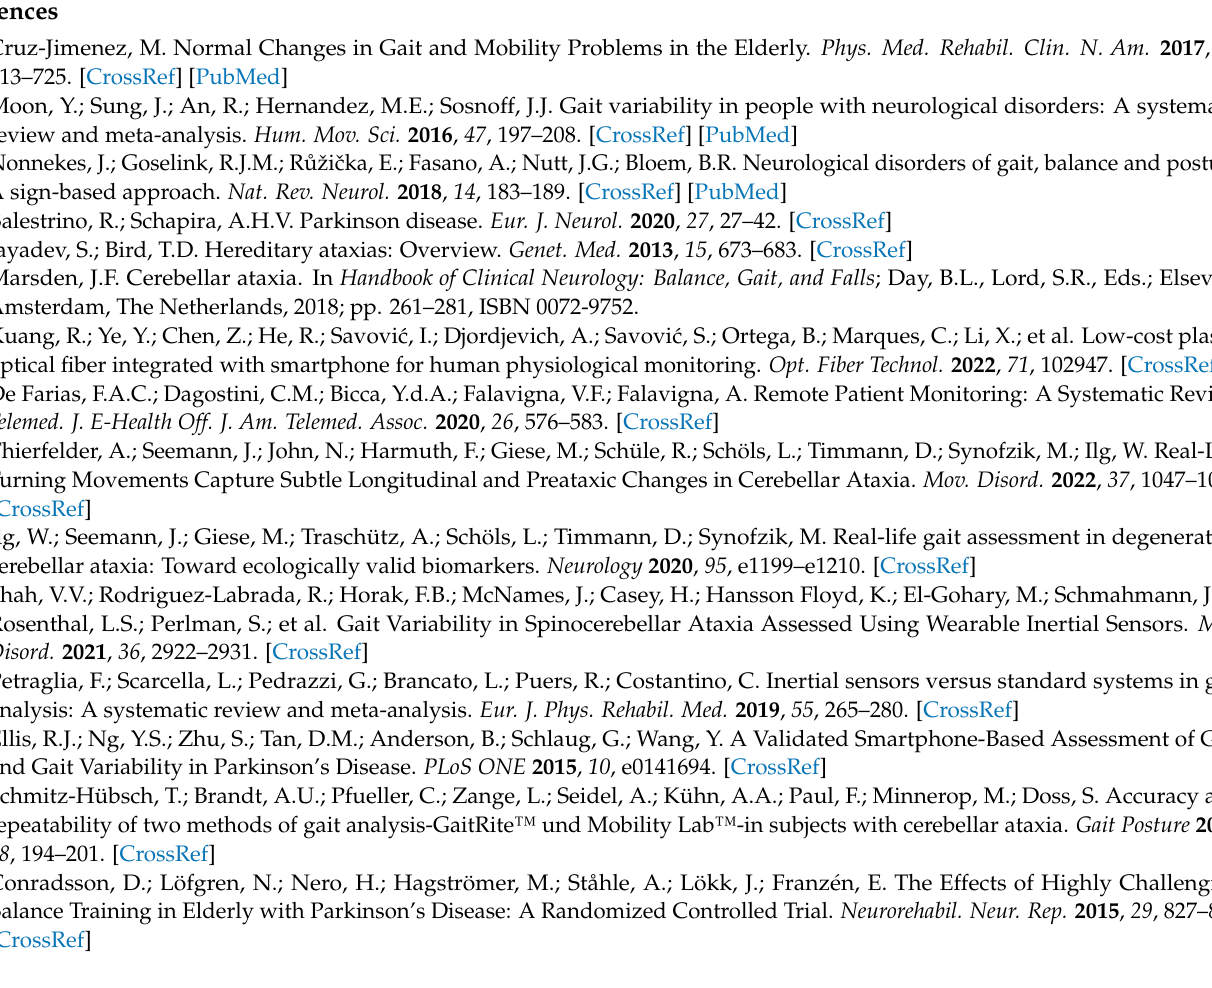
Figure A2. Exemplary visualization of the principal component-based ellipsoid calculation for balance data collected using the JTrack smartphone